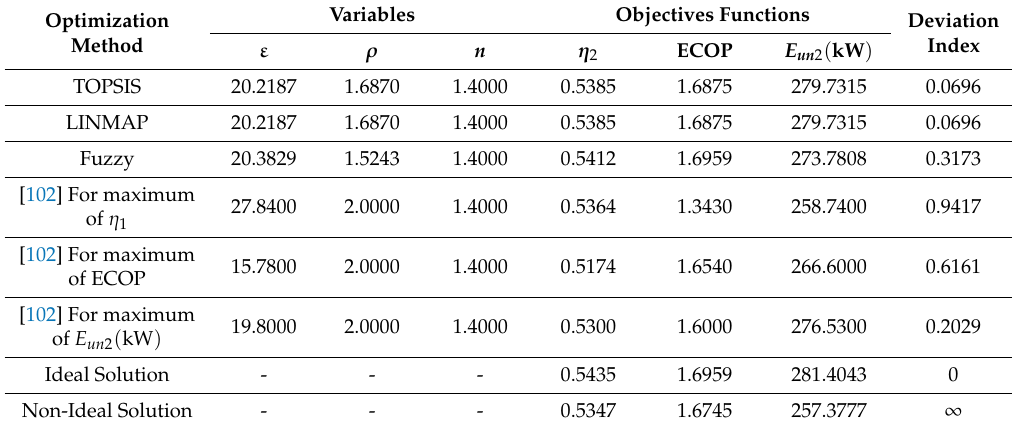
Table 3. Optimization results ( n > k ).